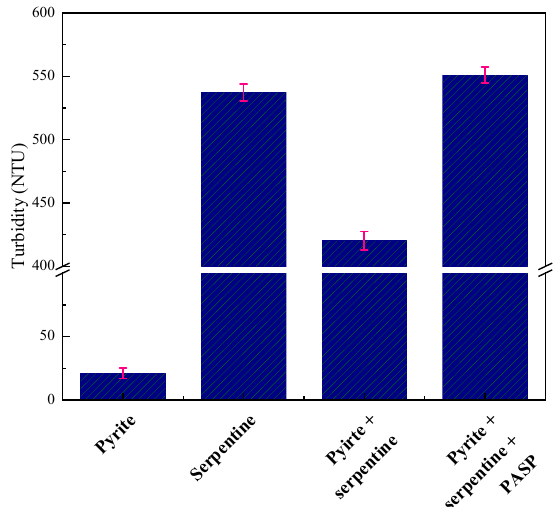
Figure 7. Turbidity of single pyrite and serpentine ( − 10 µm) and their mixture in the absence and presence of PASP (pH = 9, [PASP] = 15